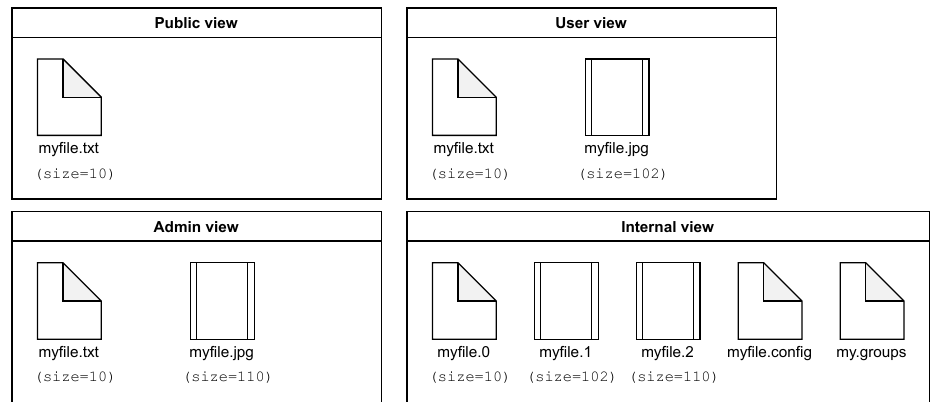
Figure 4. Multiple views of the same directory based on several users’ differing access rights, with a scheme similar to Figure